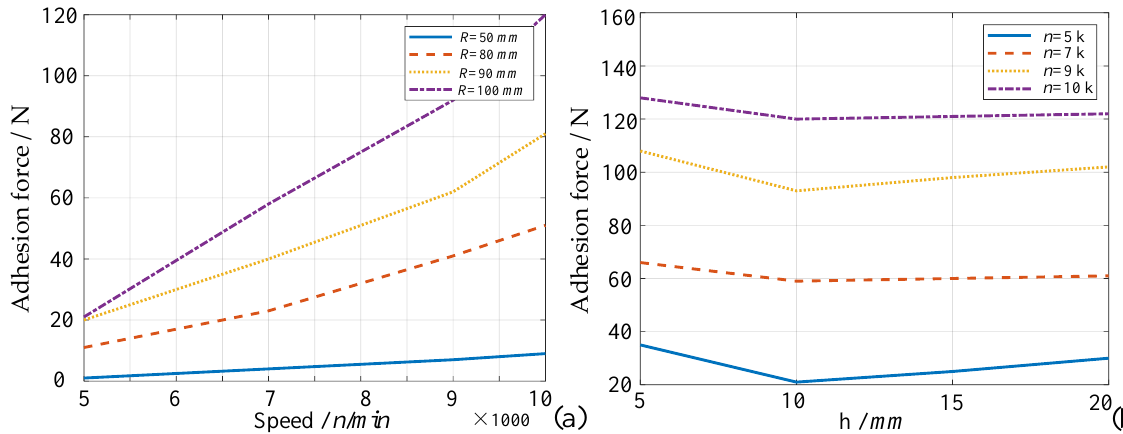
Figure 9. Simulation analysis of adhesion force. ( a ) Adhesion force as a function of speed when impeller height h = 10 mm. ( b ) Adhesion force as a function of impeller height when impeller radius R = 10 mm.